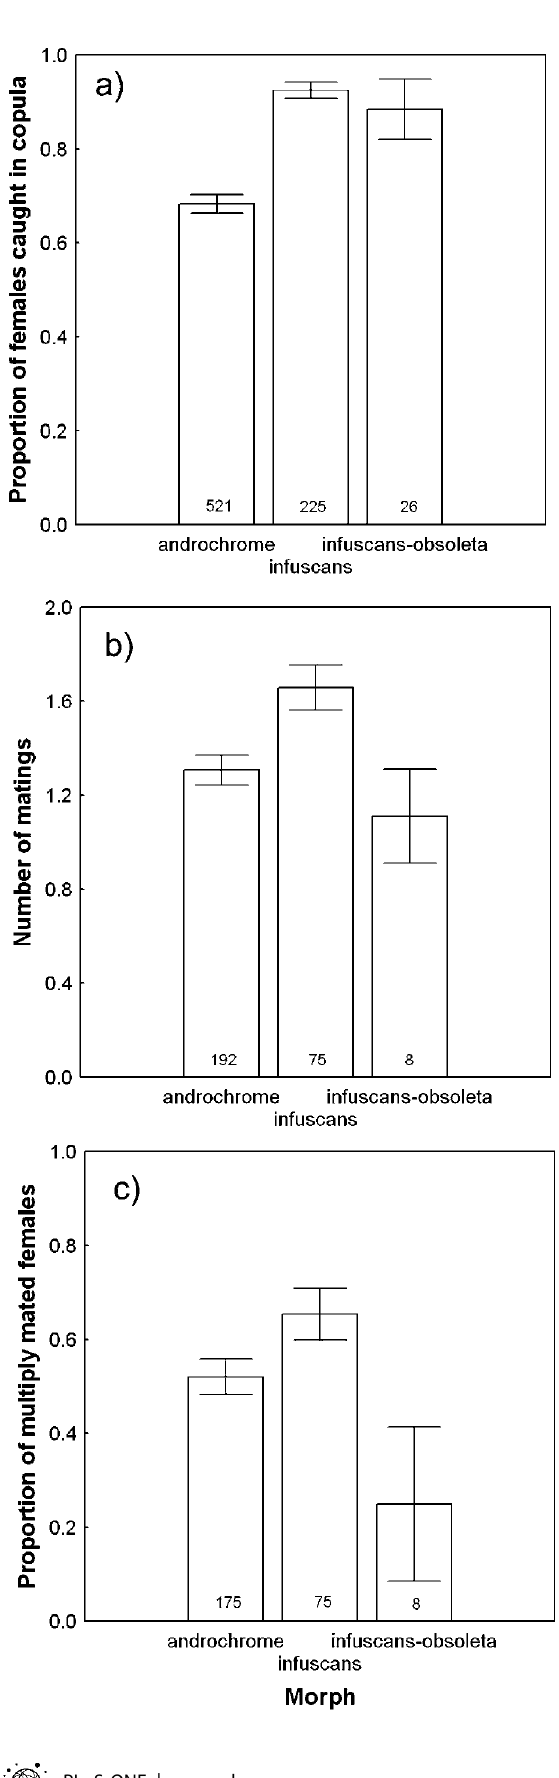
r Figure 2. Differences in mating behaviour between three female colour morphs. a) Proportion of females caught in copula in the field 6 SE ( x 2 =60.229, d.f.=2, P= , 0.001; N=772). b) Average number of matings obtained by each morph 6 SE (F 2,269 =4.014, P=0.019; N=275). Infuscans-obsoleta was not significantly different from either morph (Tukey HSD A=0.6202, I=0.1551) although the sample sizes for this morph were low (N=8). c) Proportion of multiply mated females 6 SE ( x 2 =6.981, d.f.=2, P=0.031; N=258). All tests remain significant if the rarest morph, Infuscans-obsoleta, is removed from the analysis.